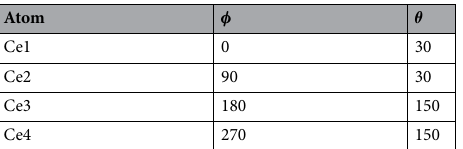
Table 4. Polar angles ( φ , θ ) which determine the spin direction of the 4 Ce atoms in 2 × 2 × 1 supercell of CeIn 3 used for noncollinear magnetism calculations using WIENncm code.